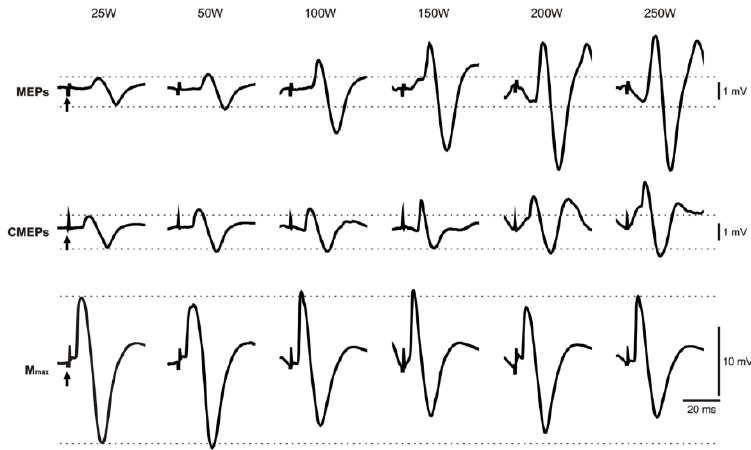
Figure 2. Raw traces for MEPs (top row), CMEPs (middle row), and M max (bottom row) from the biceps brachii of a single participant ( n = 1) across arm cycling power outputs using the weak stimulation intensity. Each MEP and CMEP waveform represent the average of six evoked potentials. Arrows indicate the stimulus artifact, and dashed lines portray the initial amplitudes of evoked potentials with the weak stimulation (~10% M max ). In this example, MEP and CMEP amplitudes show a general progressive increase as power output increases towards 250 W, while M max gradually decreases.